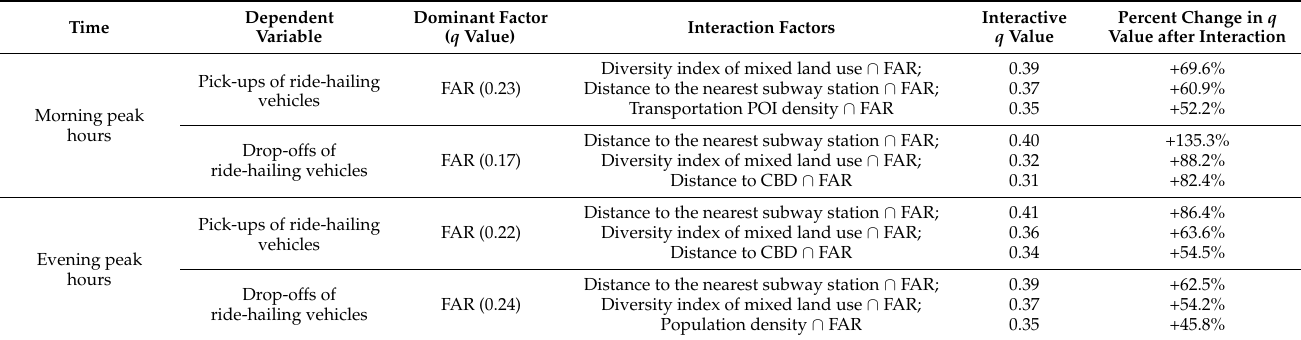
Table 6. The interactive detector results of dominant